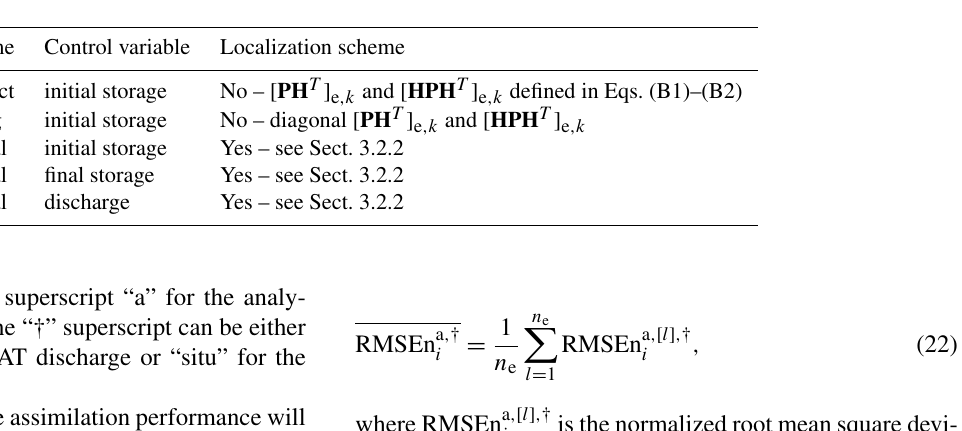
Table 3. Presentation of the different state estimation experiments. The “SE” acronym stands for “state estimation”, indexes “1”, “2” or “3” are to differentiate the control variables (“1”: initial river storage, “2”: final river storage and “3”: discharge) and the suffixes “direct”, “diag” and “local” indicate the localization scheme (“direct”: without localization, “diag”: diagonal error covariance matrices and “local”: with